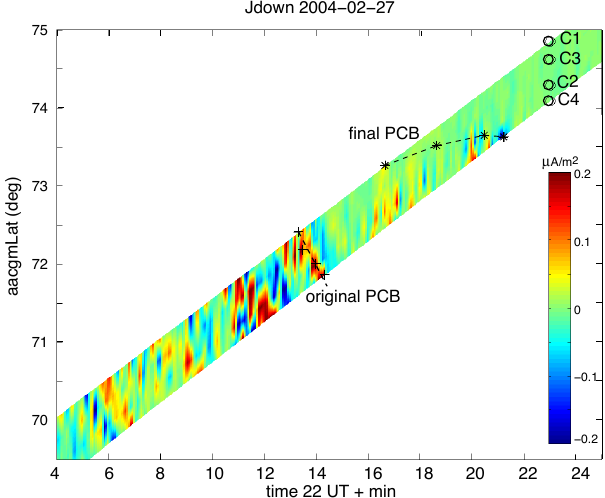
Fig. 14. Downward FAC in time-latitude coordinates. The FAC magnitude is color coded and data from all four satellites is